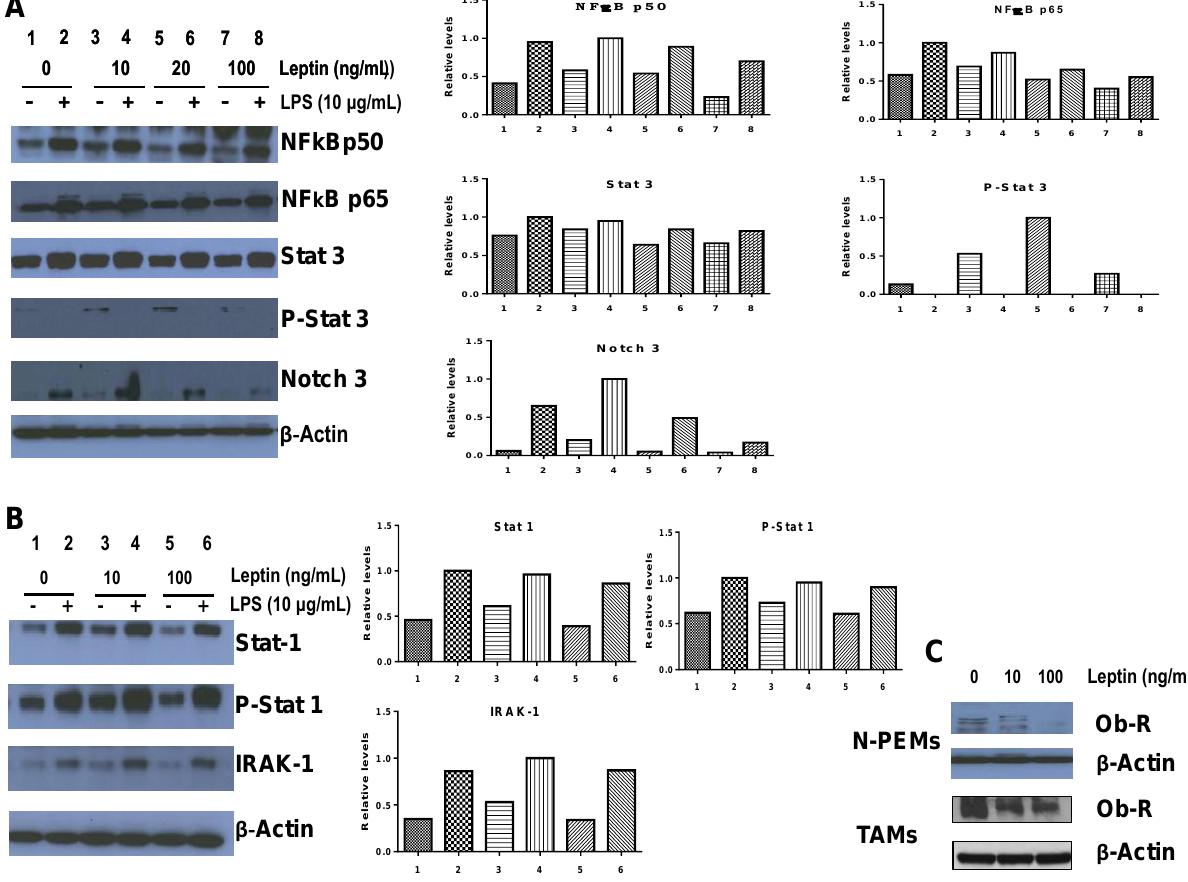
Figure 8. Leptin regulates the expression of pro-inflammatory/tumor-promoting